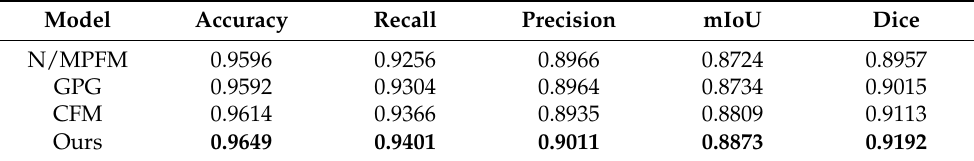
Table 5. Comparison of experimental results with or without MPFM.